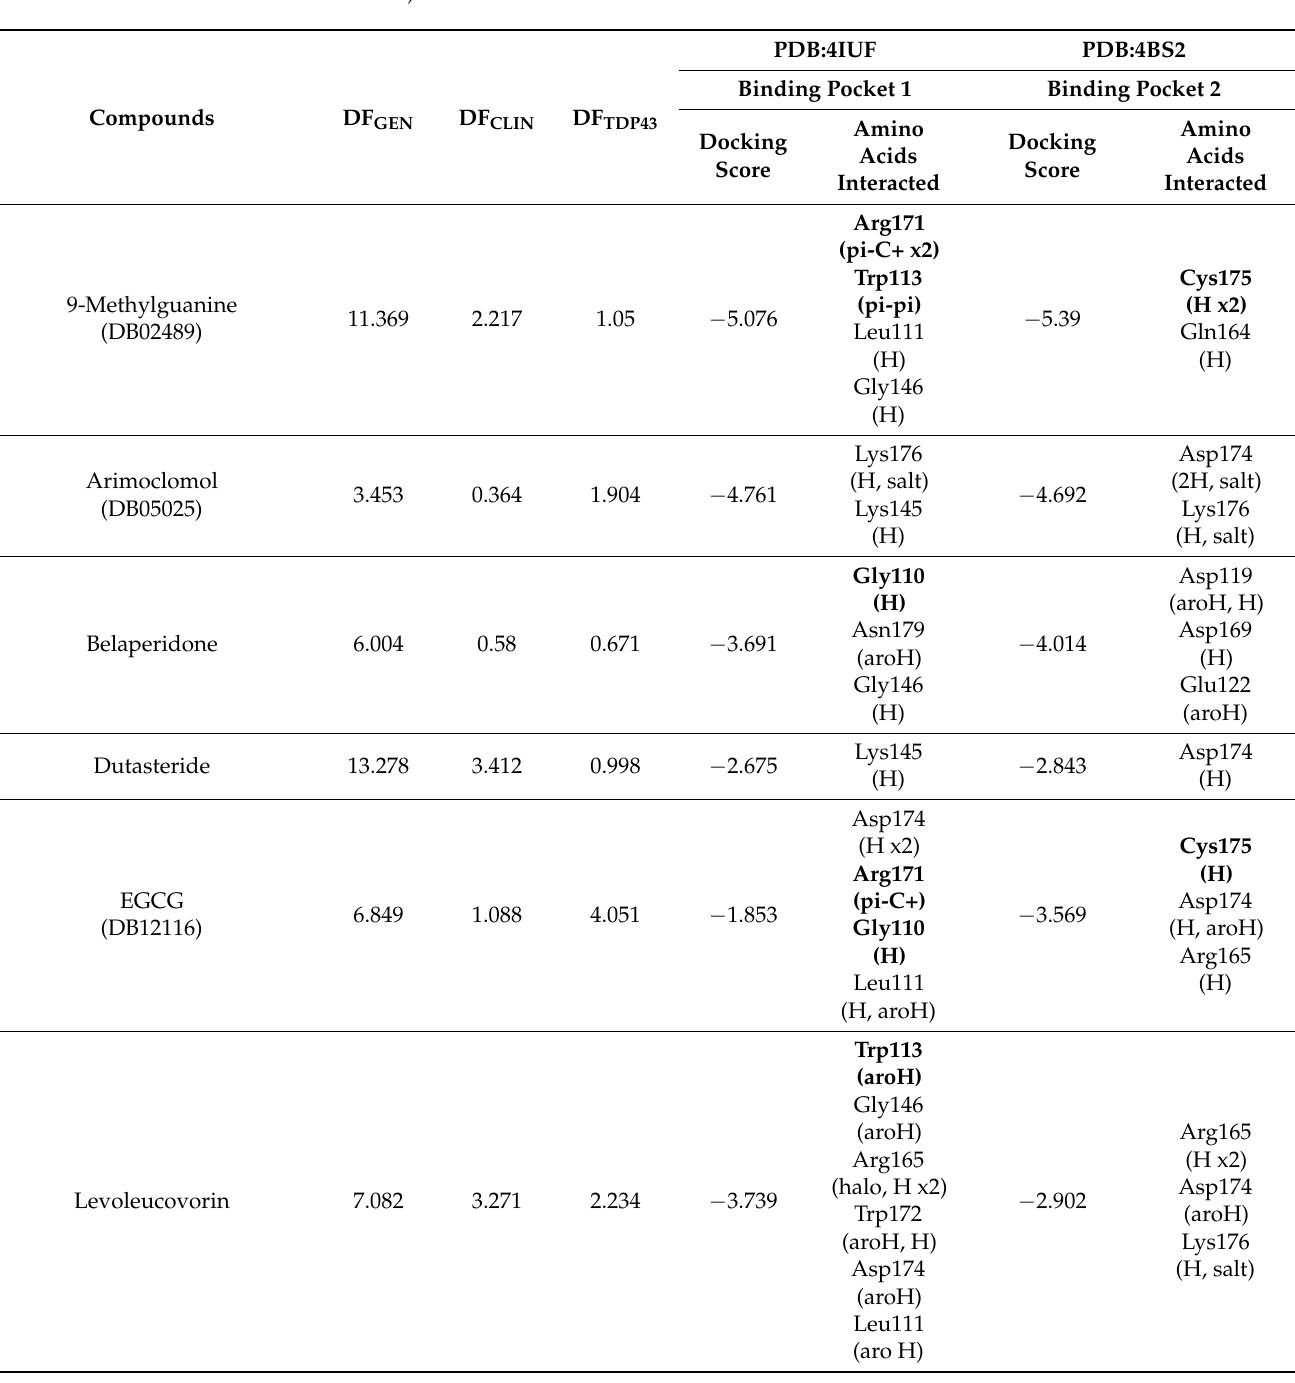
Table 4. Potential anti-ALS compounds selected by Molecular Topology and docking score (PDB:4IUF and 4BS2) for